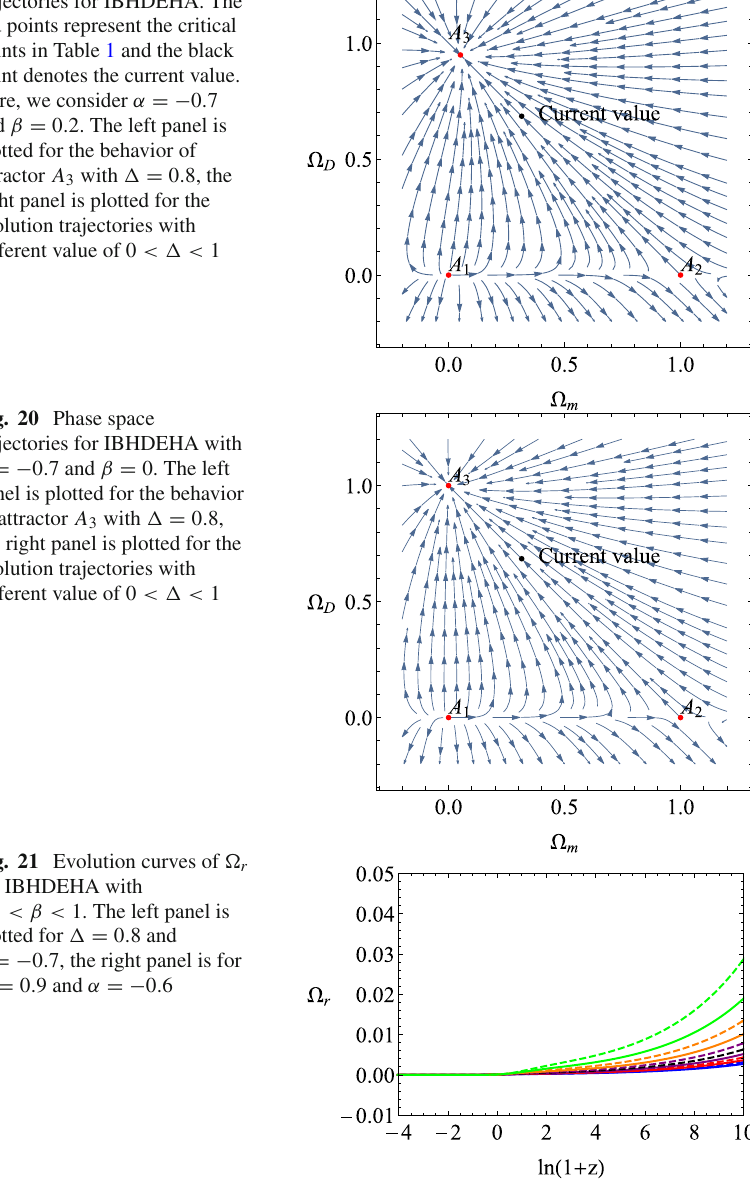
Fig. 19 Phase space trajectories for IBHDEHA. The red points represent the critical points in Table 1 and the black point denotes the current value. Here, we consider α = − 0 . 7 and β = 0 . 2. The left panel is plotted for the behavior of attractor A 3 with (cid:5) = 0 . 8, the right panel is plotted for the evolution trajectories with different value of 0 < (cid:5) < 1